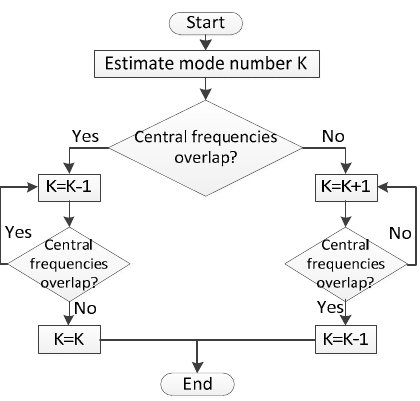
Figure 1. Method for determining the number of variational mode decomposition (VMD) modes.